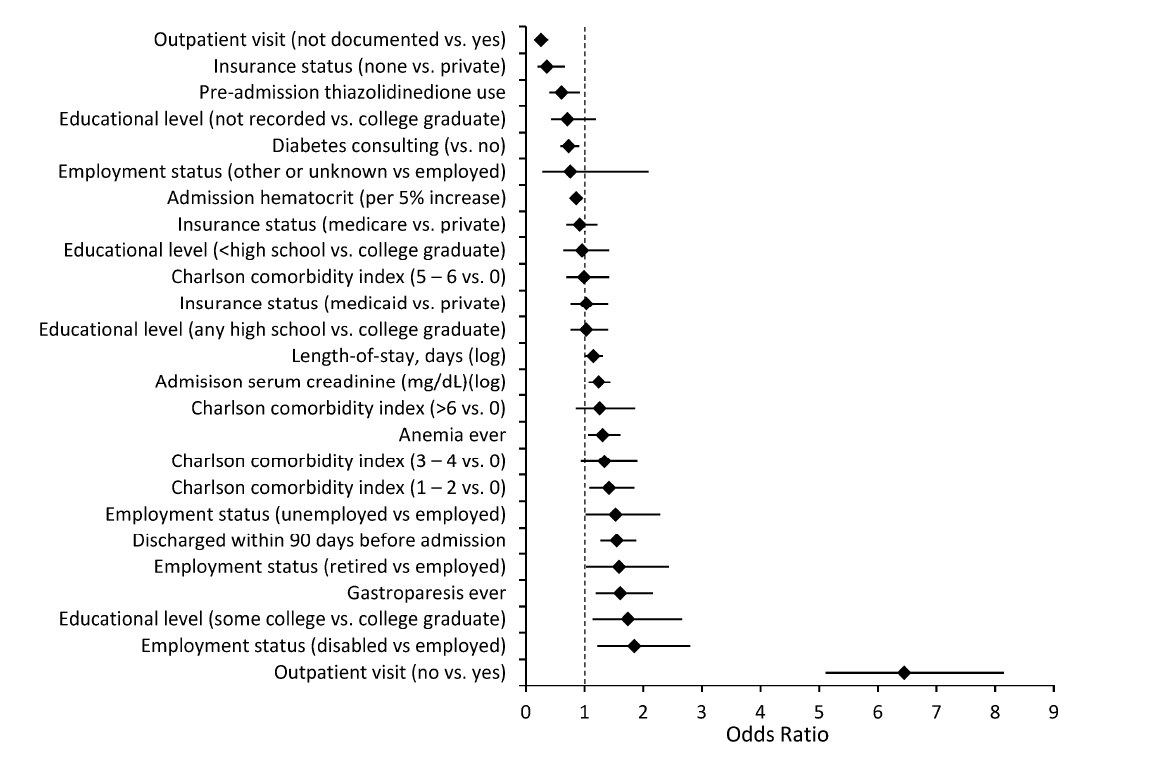
Figure 1. Risk factors for all-cause 30-day readmission among 4027 patients with primary discharge diagnosis of diabetes in multivariable logistic regression model, OR (95% CI), adjusted for year of discharge. (cid:7) = Odds ratio.